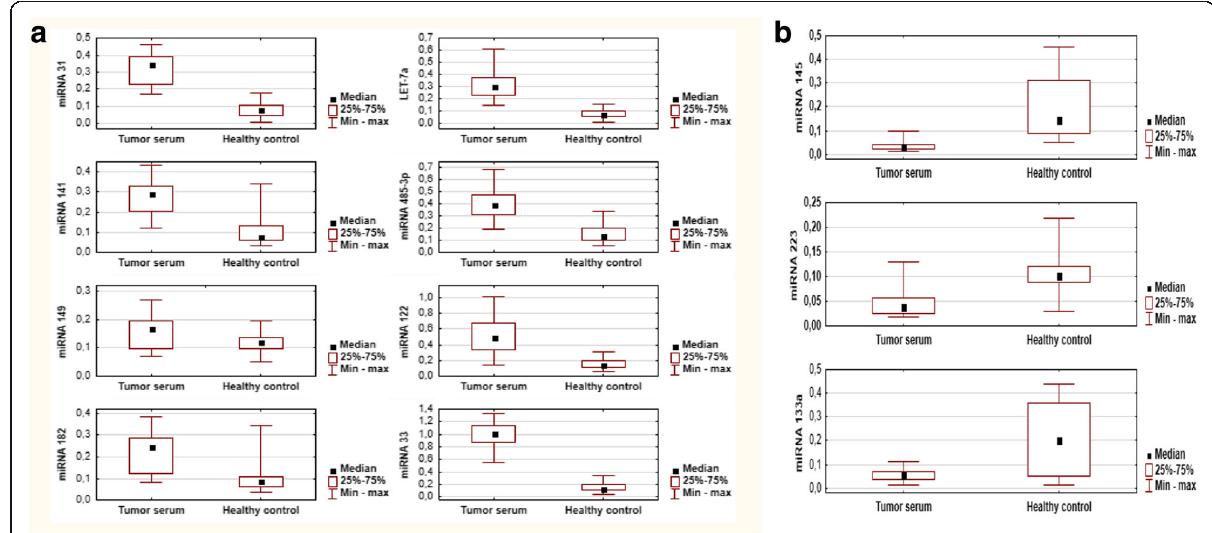
Fig. 2 The qRT-PCR results of differential miRNAs. a Elevated expression of eight miRNAs in serum of LSCC patients compared with healthy individuals (healthy controls). The levels of miR-31, miR-141, miR-149a, miR182, LET-7a, miR-4853p, miR-122, miR-33 was measured in serum samples from LSCC ( n =66) and healthy control individuals ( n =100). b Down-regulated expression of miR-133a, miR223 and miR-145. Data represent the